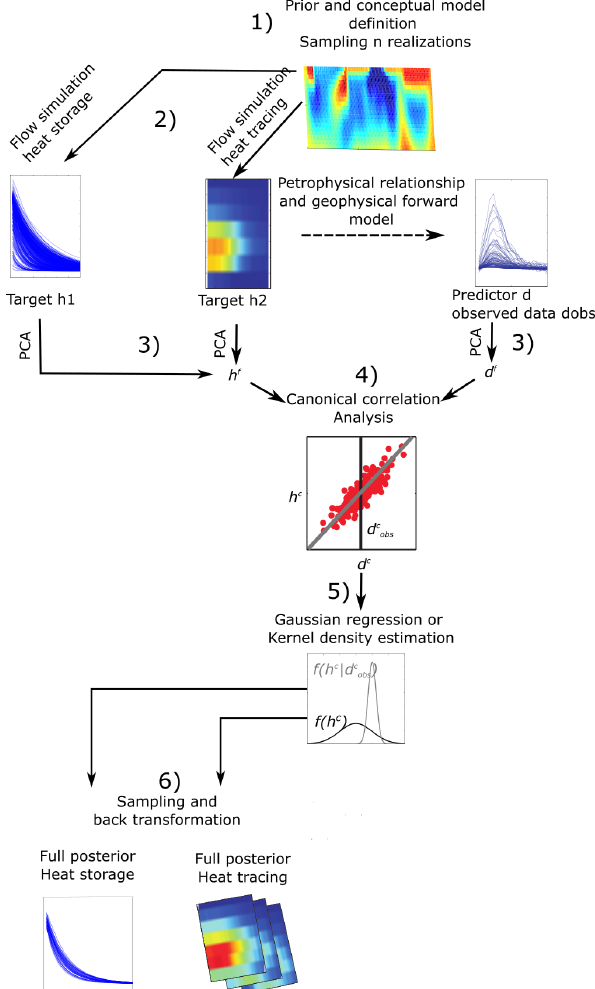
Figure 7. Framework of Bayesian Evidential Learning applied to the prediction of heat storage in an aquifer from a tracer exper- iment monitored by geophysics. (1) A prior model of the spatial heterogeneity is defined and sampled. (2) Both the predictor (data set such as a tracer experiment) and the target (prediction of heat storage) are simulated. For the predictor, a petrophysical transform is used to generate the corresponding geophysical data. (3) Dimen- sion reduction techniques are applied to both data and prediction. (4) A statistical relationship between data and prediction is learned. (5) The posterior distribution of the prediction for field observed data is generated using the statistical relationship. (6) The posterior is back-transformed in the physical space (modified from Hermans et al.,